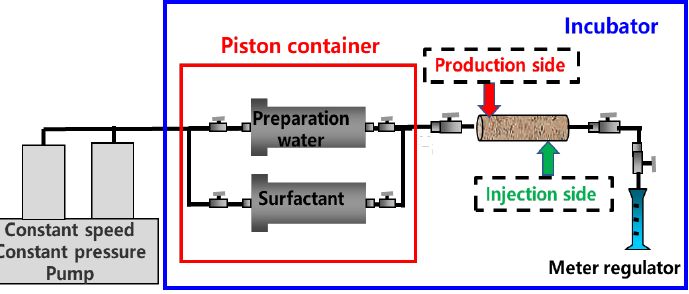
Schematic diagram of water flooding core displacement experimental device.